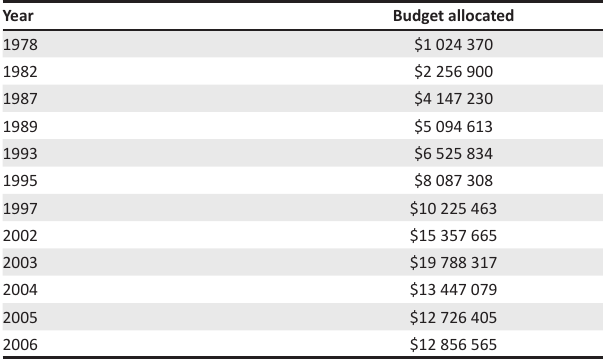
TABLE 4: Budget allocated to corrupt practices investigation bureau by Singapore’s government